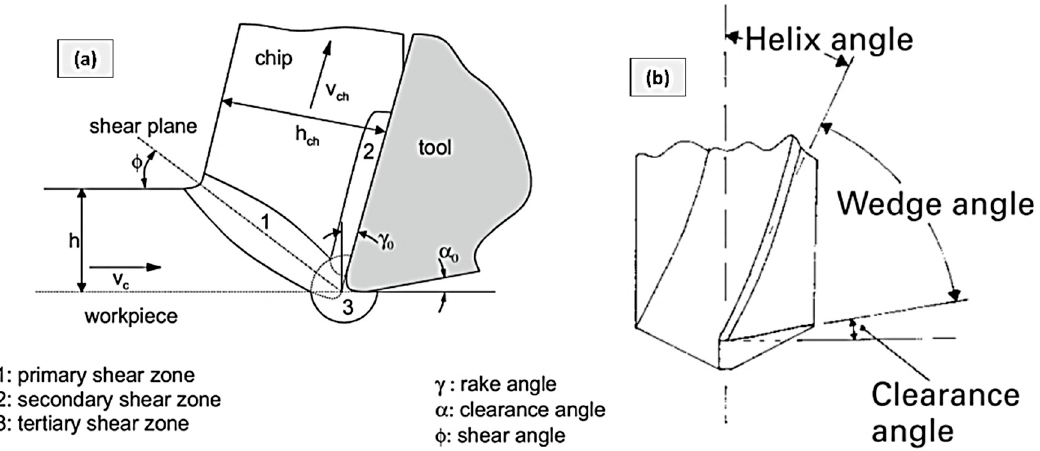
Figure 6. Schematic representation of ( a ) material removal and heat generation regions during chip forming process; ( b ) rake and relief angles [2].